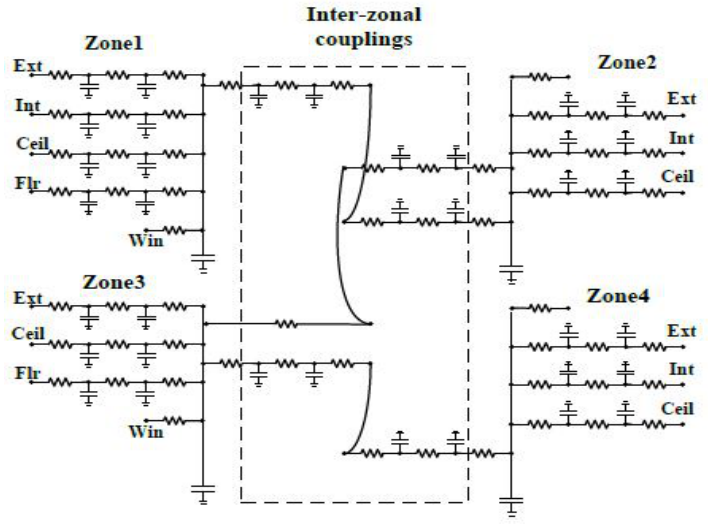
Figure 5. Resistor capacitance thermal network for multi-zone building